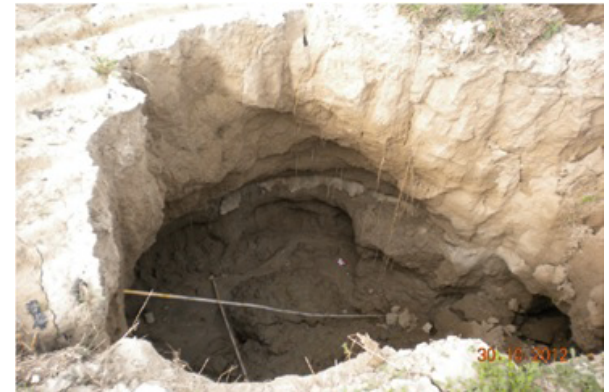
Figure 1. Location of the Puerto Lumbreras earth fissure and the locations of signs of piping and sample collection (modified from Mulas, 2013). Orthophoto from PNOA 2019 CC-BY scne.es.